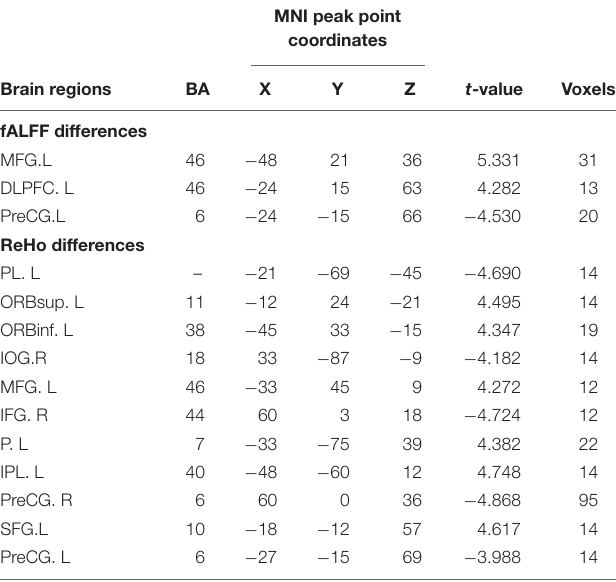
TABLE 2 | Regions showing significant differences in fALFF and ReHo values between PPD and HCs.